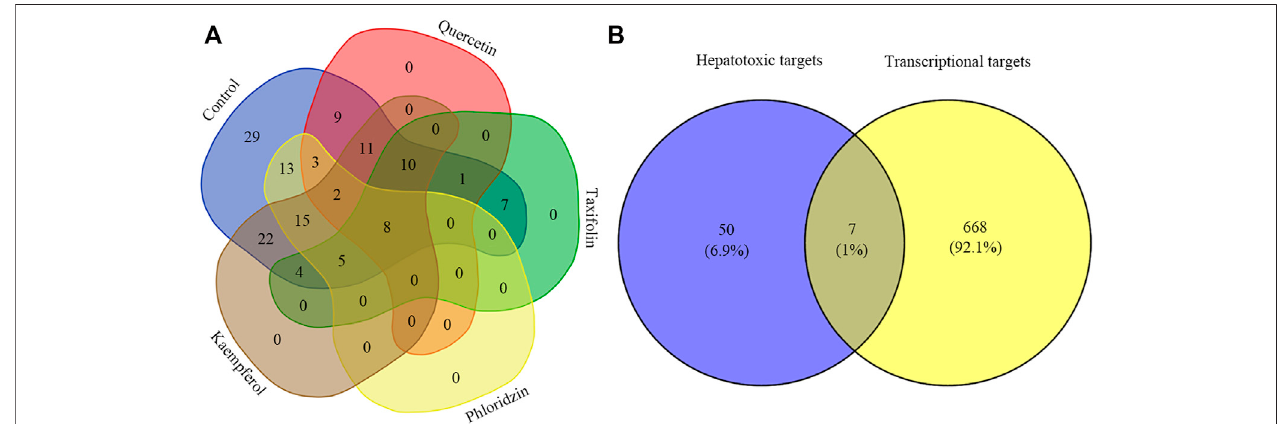
FIGURE 4 | Venn diagram of transcriptome analysis. Graph (A) indicates the distribution of GO functions enriched by vine tea components as perturbation factors similar to the GO functions enriched by the reference expression pro fi le; graph (B) indicates the intersection of transcriptional targets hit by hepatotoxic targets and liver injury-related GO